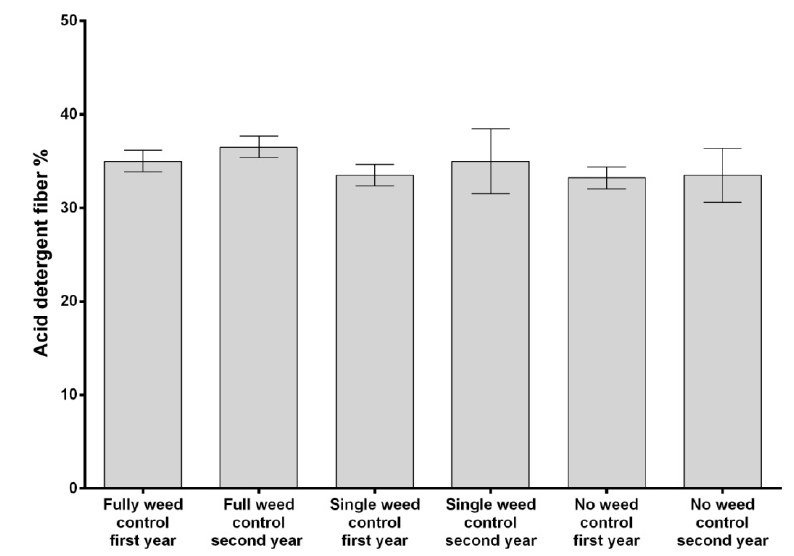
Figure 3. Mean comparison by year of the effect of weed management on acid detergent fiber. All measurements were performed in triplicate. Data are shown as the mean ± standard deviation. There were no significant differences.